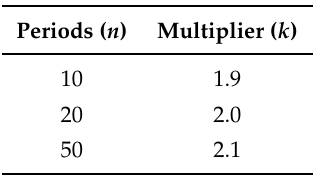
Table 1. Recommended Width Parameters for Bollinger